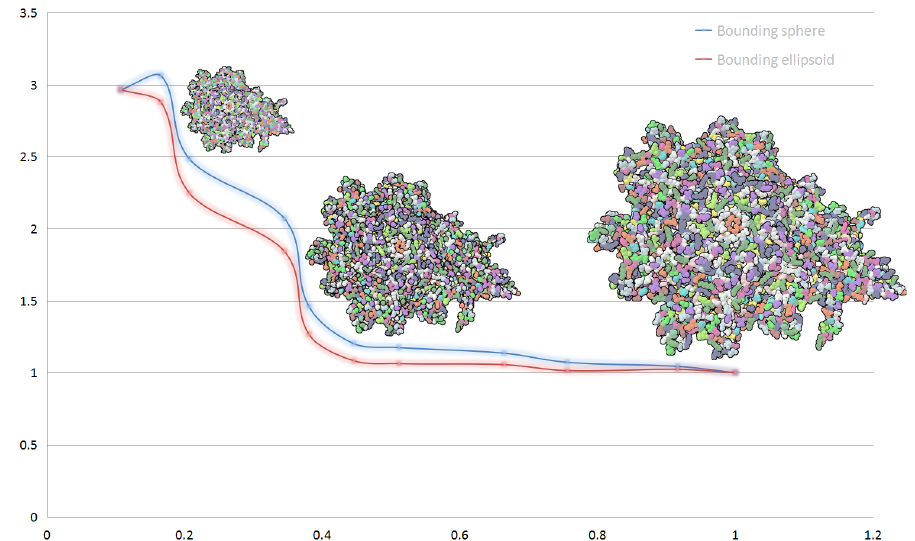
Figure 2. Performance evaluation of hierarchical representation. The horizontal axis of chart represents the ratio of the cluster render list size to the full atom count. The vertical axis represents the speed-up of rendering performance of hierarchical representation to full vdW representation.